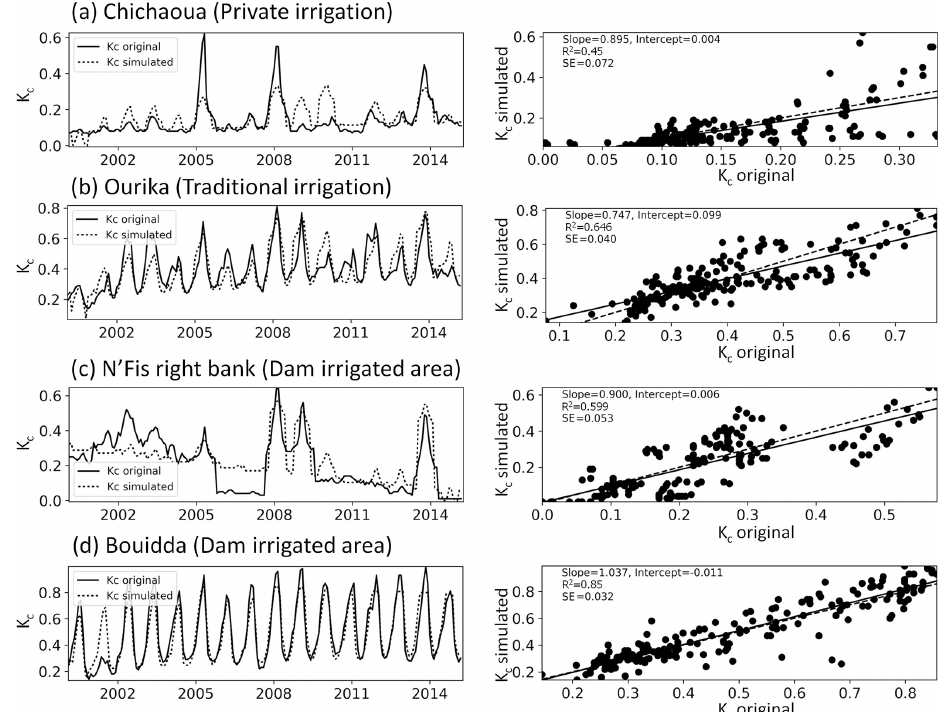
Figure 5. Examples of K c simulations compared to the original time series for four selected areas.